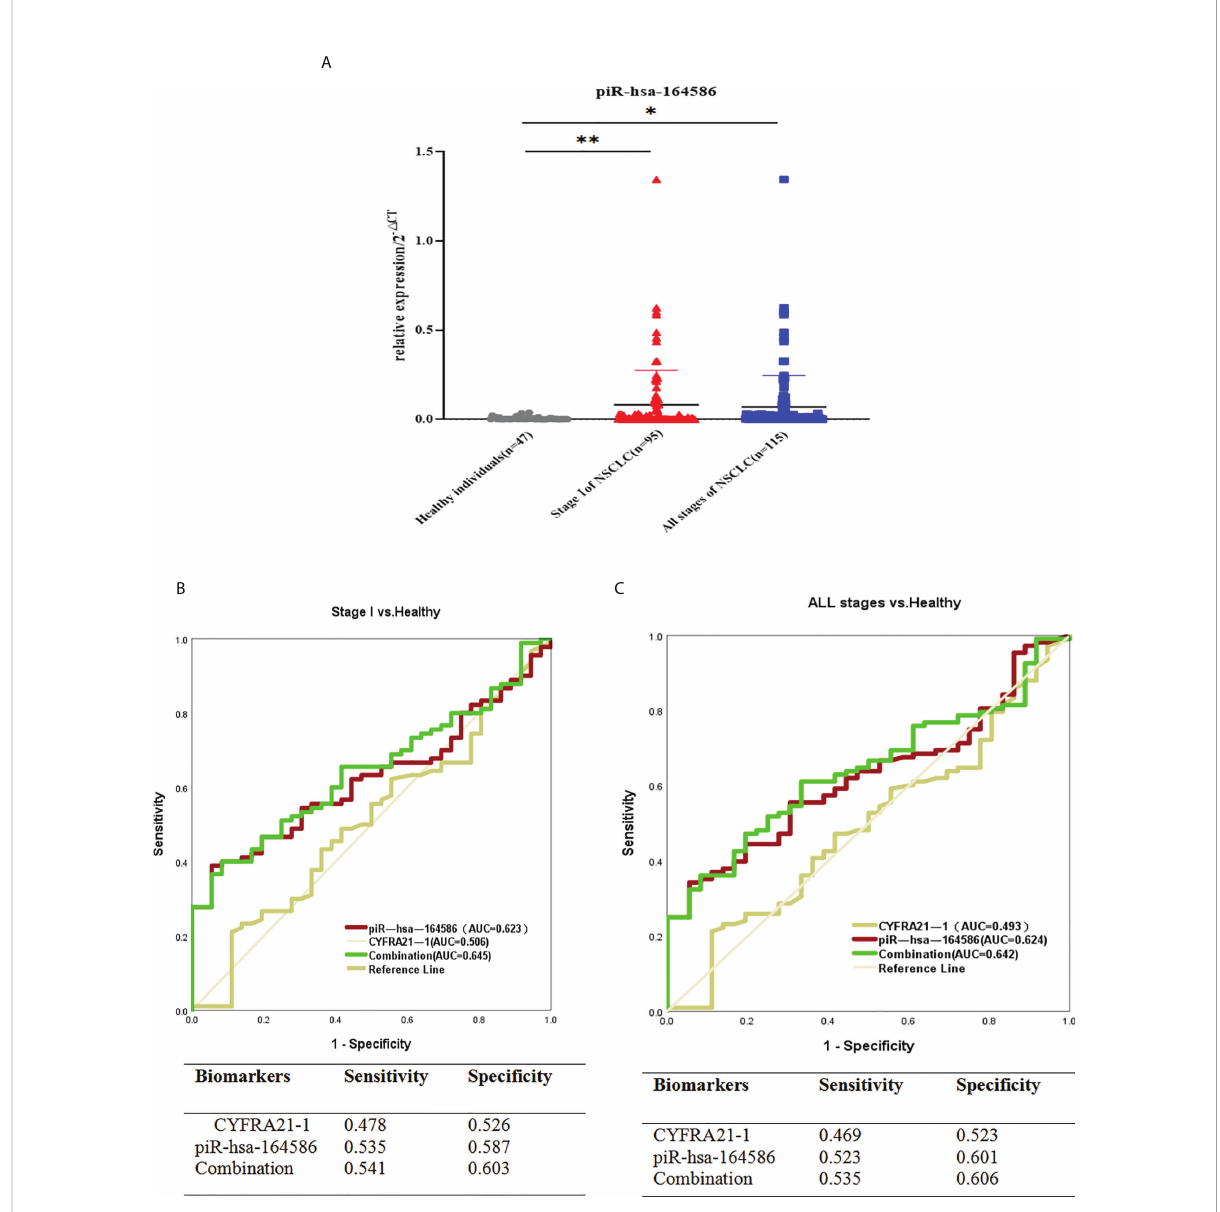
FIGURE 4 Serum-derived piR-hsa-164586 of extracellular vesicles is a potential biomarker for NSCLC patients. (A) qRT-PCR analysis the expression level of piR-hsa-164586 of extracellular vesicles in patients with stage of NSCLC (n = 95), all stage of NSCLC (n = 115) and healthy persons (n = 47). (*p < 0.05,**p < 0.01); (B, C) ROC curve analysis for piR-hsa-164586 of extracellular vesicles in distinguishing stageor all stage of NSCLC from healthy